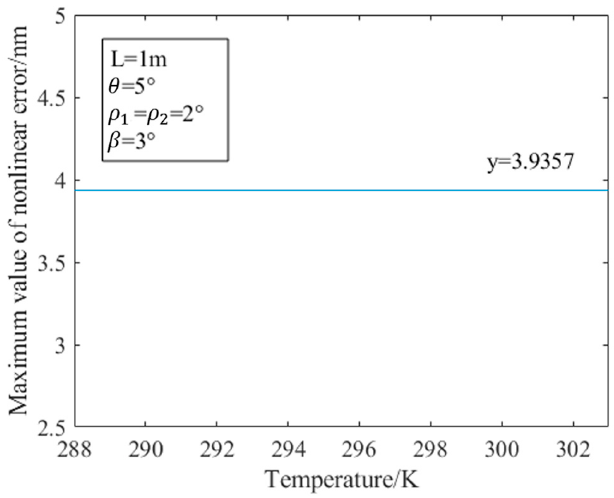
Figure 6. Simulation result of the in fl uence of temperature change on nonlinear error.